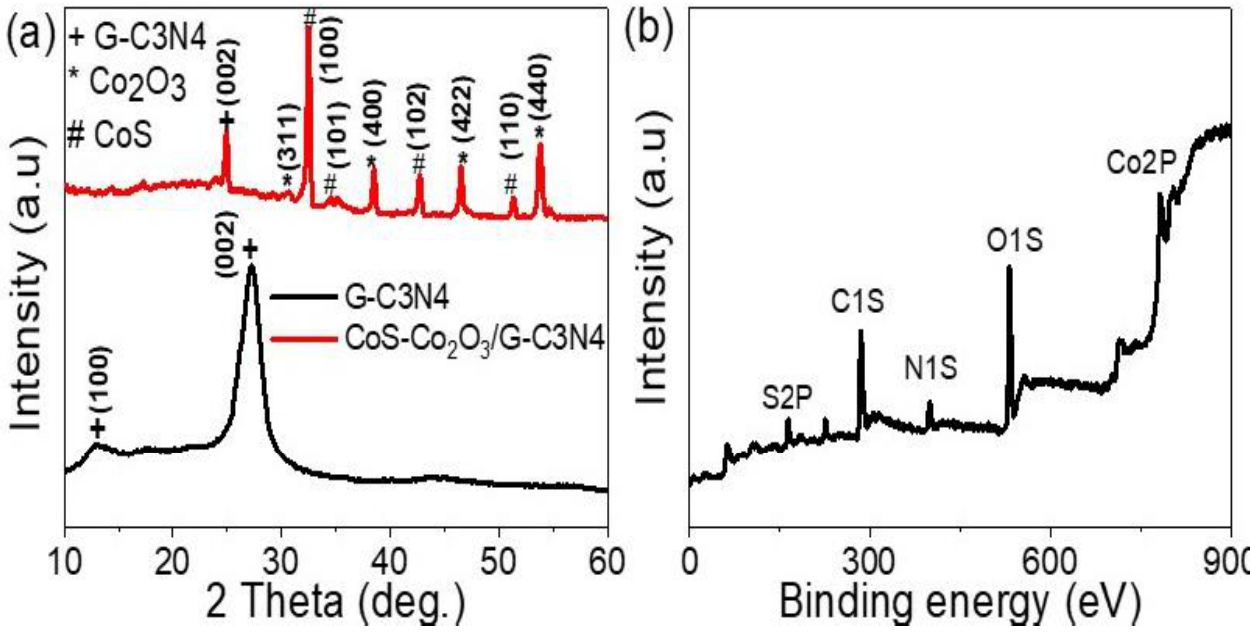
Figure 1. ( a ) XRD of G-C3N4 and CoS-Co 2 O 3 /G-C3N4 composite and ( b ) XPS of CoS-Co 2 O 3 /G-C3N4 composite.